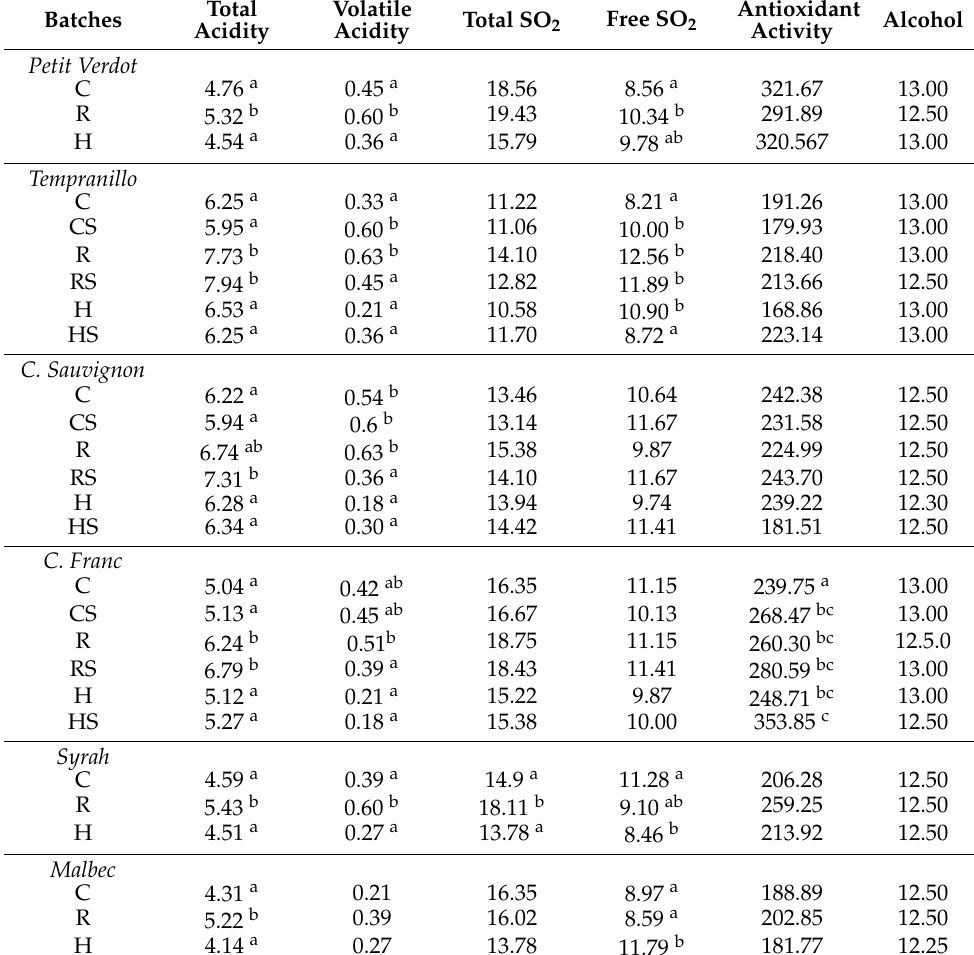
Table 7. Physicochemical parameters performed on batches of various wines at the end of the storage period (C: control batch, CS: control batch with sulfur dioxide; R: batch of scratch, RS: batch of scratch plus sulfur dioxide, H: batch of skin and HS: batch of skin plus sulfur dioxide). Total Batches